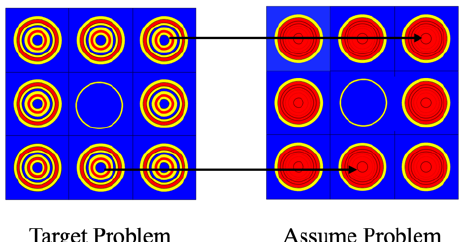
Figure 1. The conversion process for multi-annular fuel